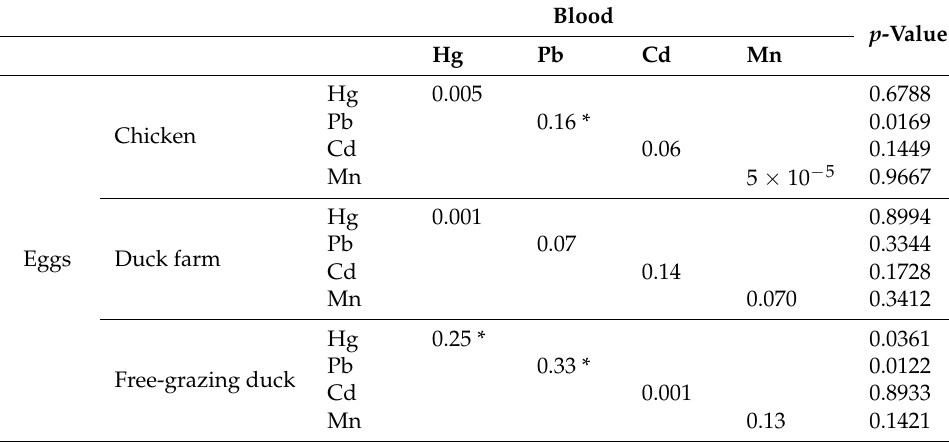
Table 3. Correlations between Hg, Pb, Cd, and Mn in eggs and blood (r 2